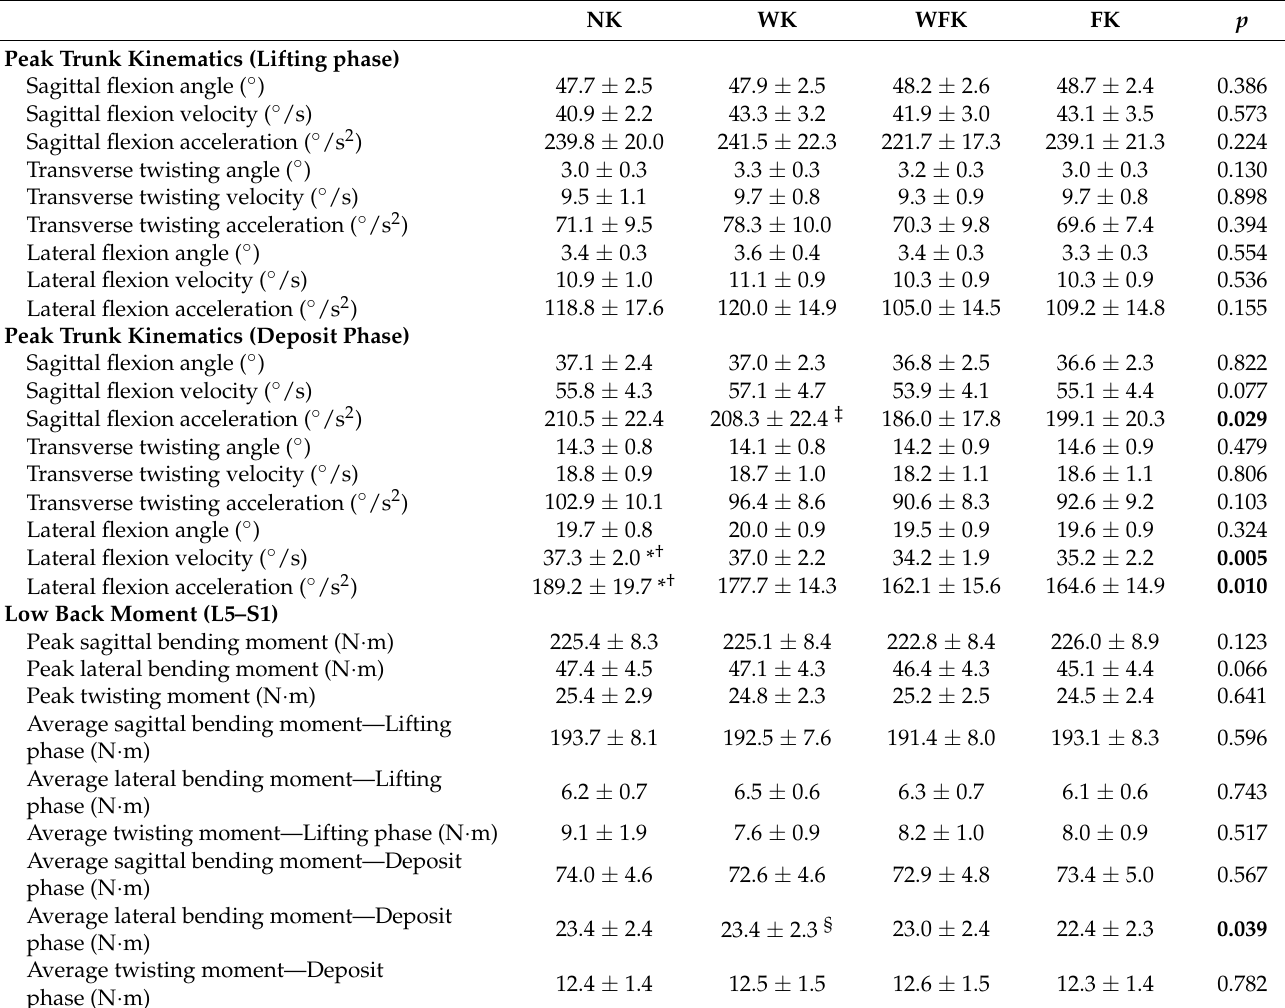
Table 1. Main effects of load knowledge: Mean ± SD.